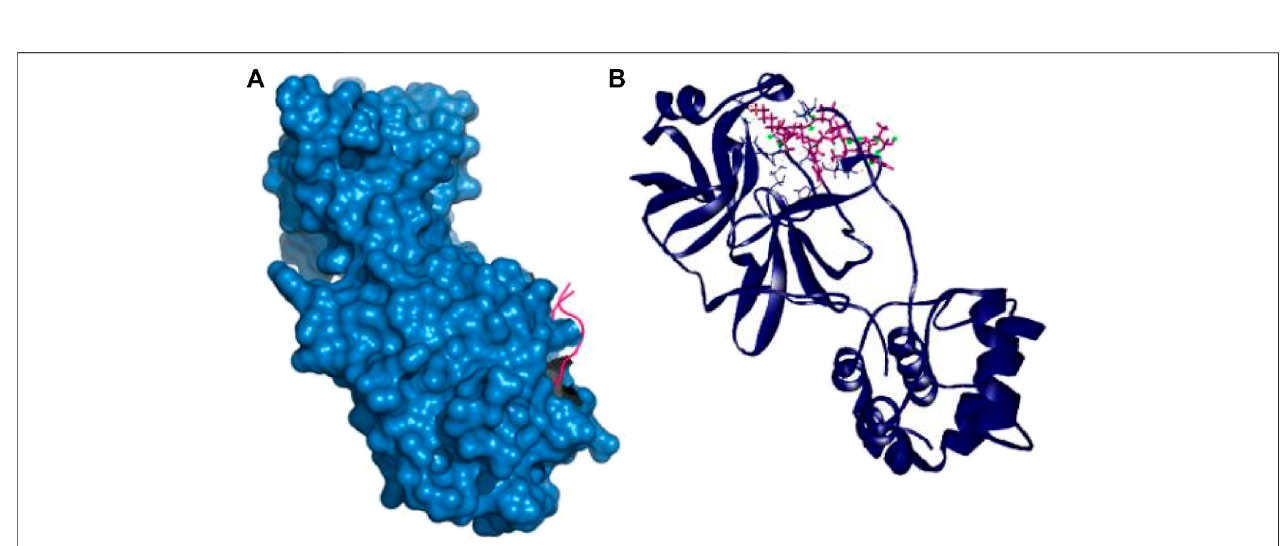
FIGURE 1 | Docking interaction with P14 peptide and main protease enzyme of SARS-CoV-2 (A , B) .